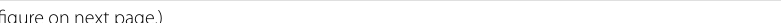
figure on next Fig. 8 Periprostatic dermoid cyst a Coronal T1W image shows a large well-circumscribed mass in the pelvis (white arrows) which is mildly T1 hyperintense to muscle, shows mild fat saturation on ( b ) axial T1 fat saturation sequence. c Axial T2W image shows the lesion is high T2 signal compared to muscle. It causes significant mass effect on the bladder (red arrow) displacing it anteriorly and exerts mass effect on the prostate and seminal vesicles. d Post-contrast T1 shows no significant enhancement. The lesion shows strong diffusion restriction with ( e ) high DWI and ( f ) low ADC. No evidence of calcification, fluid–fluid level or suspicious enhancing nodular soft tissue thickening was